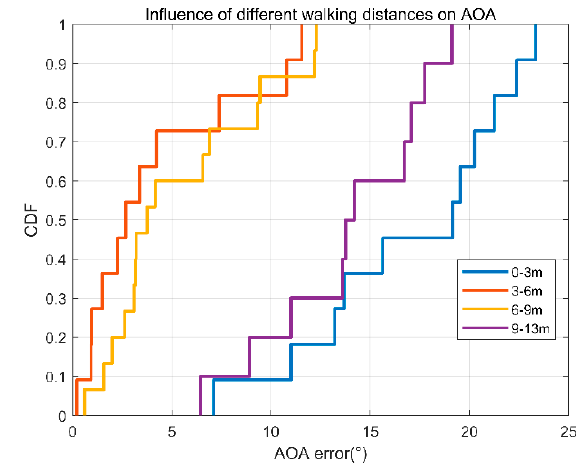
Figure 19. AOA error accumulation diagram of four different walking distances.